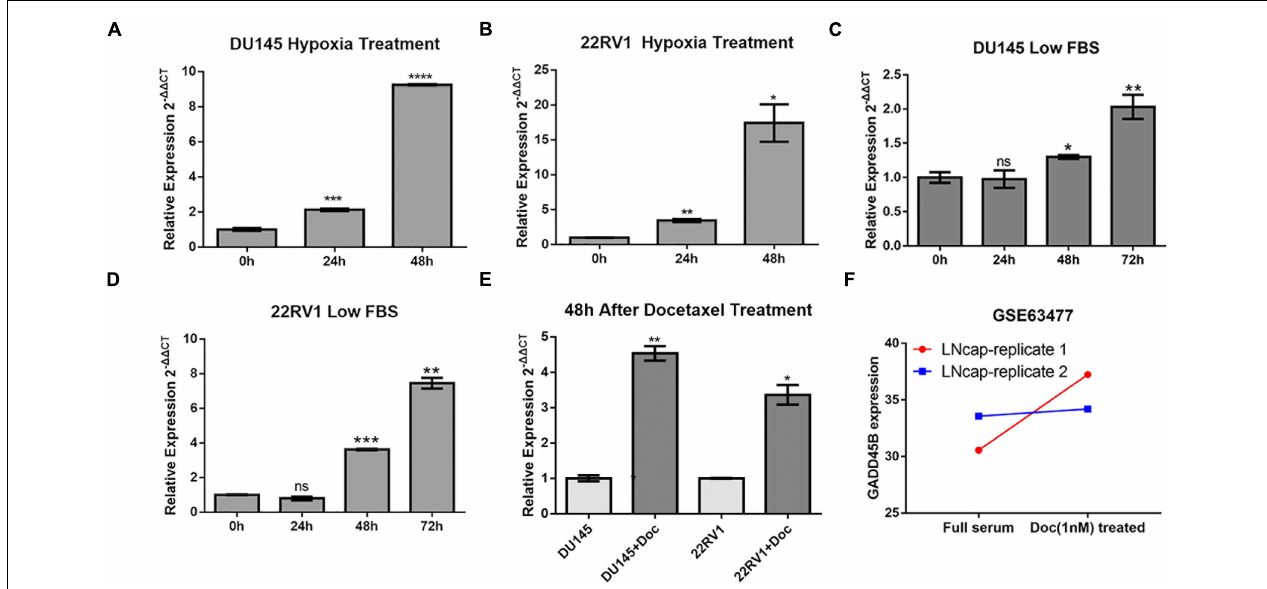
FIGURE 3 | GADD45B increased significantly in cells with environmental stresses and docetaxel treatment. RT-PCR analysis of GADD45B levels in DU145 and 22RV1 cells with hypoxia (A,B) , low serum (C,D) , and docetaxel stimulation (E) . (F) The expression of GADD45B in a docetaxel treatment dataset. * p < 0.05, ** p < 0.01, *** p < 0.001, **** p < 0.0001, and not statistically significant p > 0.05.